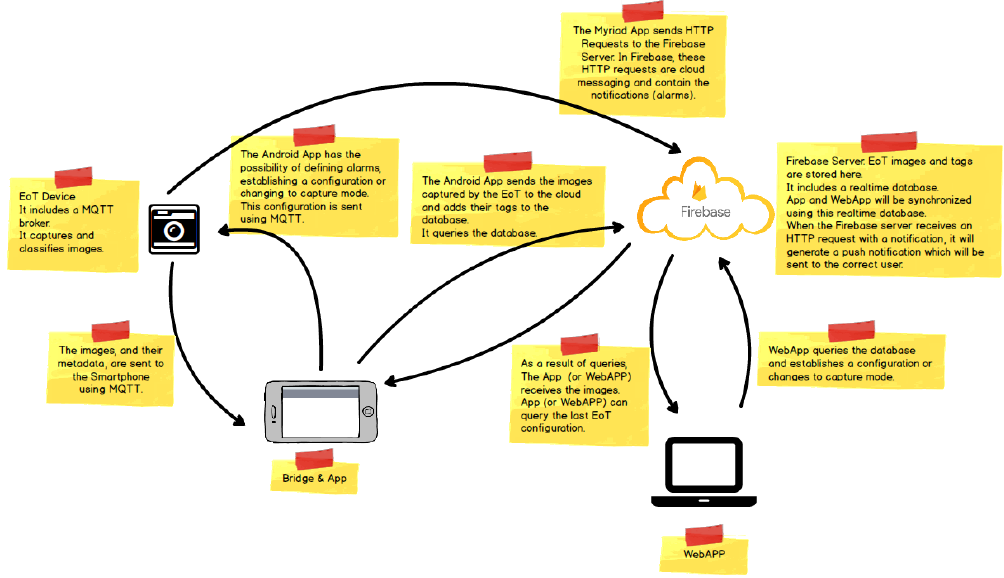
Figure 21. Architecture of the versatile mobile camera